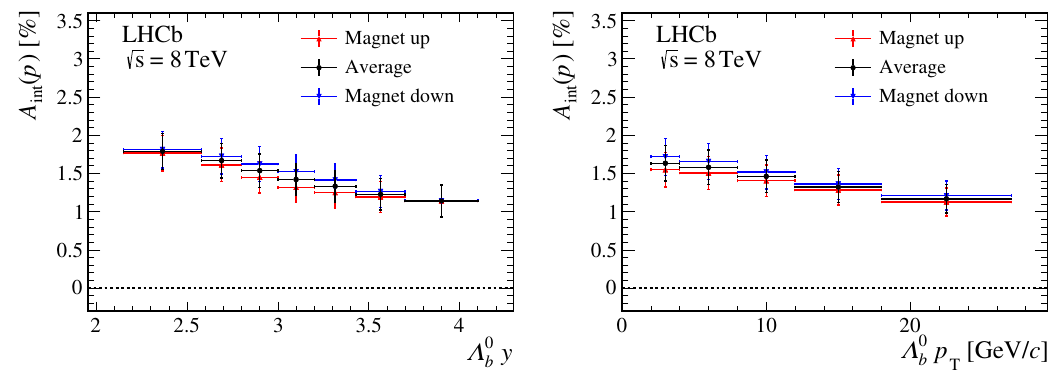
Figure 7 . Proton-interaction asymmetry versus (cid:3) 0 (left) rapidity and (right) p T for data taken at b a centre-of-mass energy of p s = 8 TeV. The results are shown separately for (red upward triangles) magnet up, (blue downward triangles) magnet down and (black dots) their